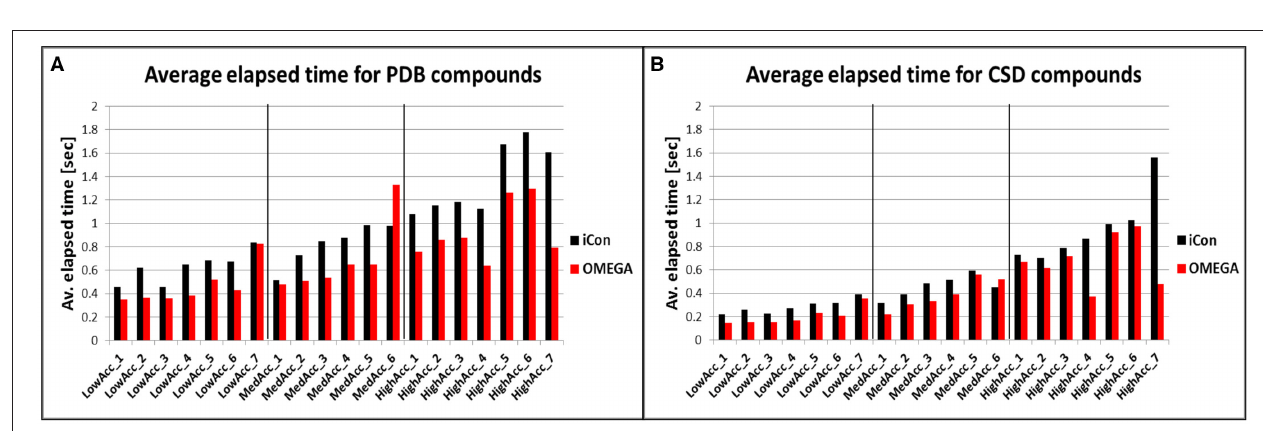
FIGURE 7 | Average time required for the conformational sampling of PDB (A) and CDS (B) compounds with iCon and OMEGA, by using the different setting patterns. Black vertical lines are used to separate the three different groups of